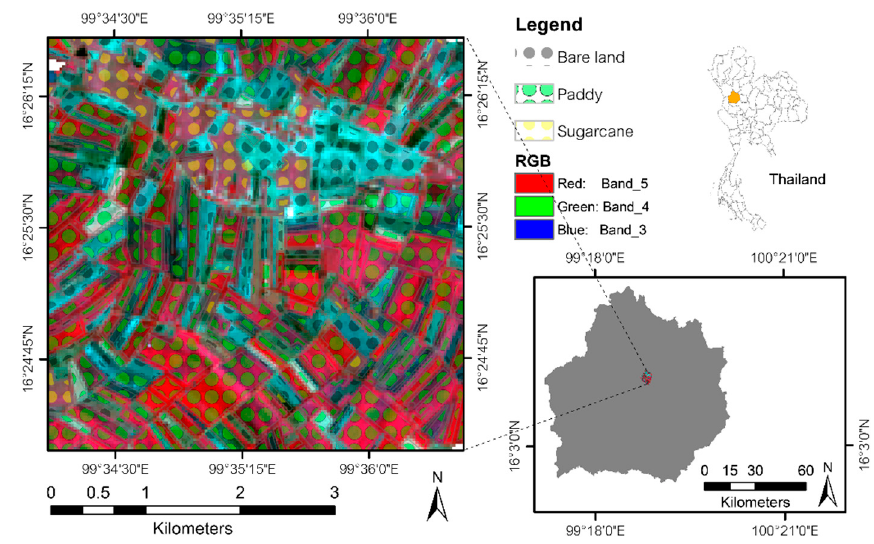
Figure 2. The location of PS data, Left band 5 (R), 4 (G), 3 (B) composite of the Landsat 8 OLI image.